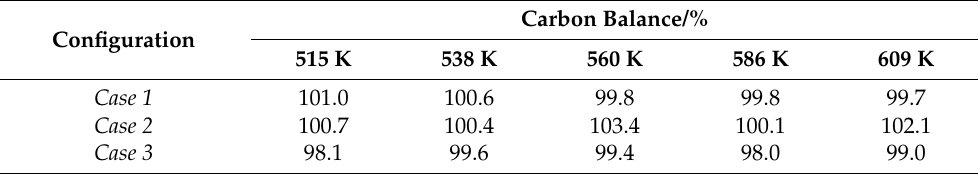
Figure 6. Comparison of CO yields obtained in ◦ , Case 1 ; ▵ , Case 2 and □ , Case 3 . The dashed line shows the equilibrium yield. Table 2. Carbon balances in each reactor.